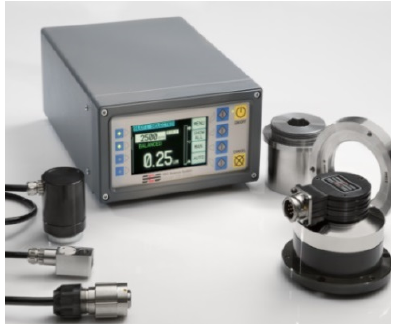
Figure 4. Balance device diagram.